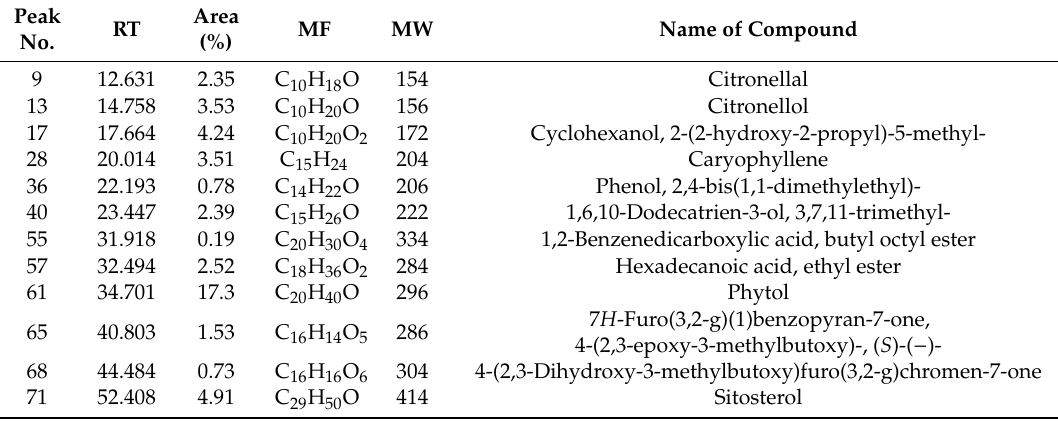
Table 5. Proposed phytochemical constituents in Citrus hystrix leaves (CHL) compared with the NIST database. Peak No.